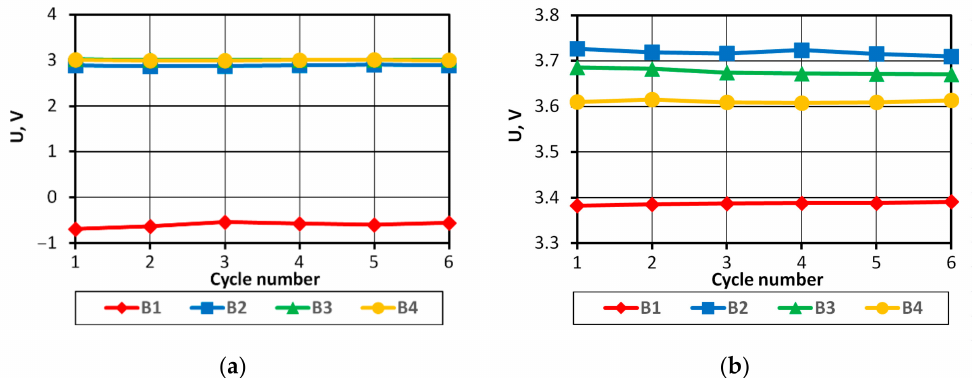
Figure 8. Battery voltages at the end of successive discharging/charging cycles with the UCT100-6- type charger: ( a ) end of discharging; ( b ) end of